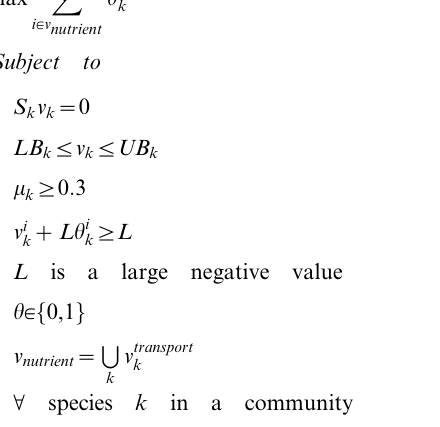
Figure S3 Metabolic reprogramming in an E. coli / B. subtilis community, resulting in emergent secretion of both succinate and